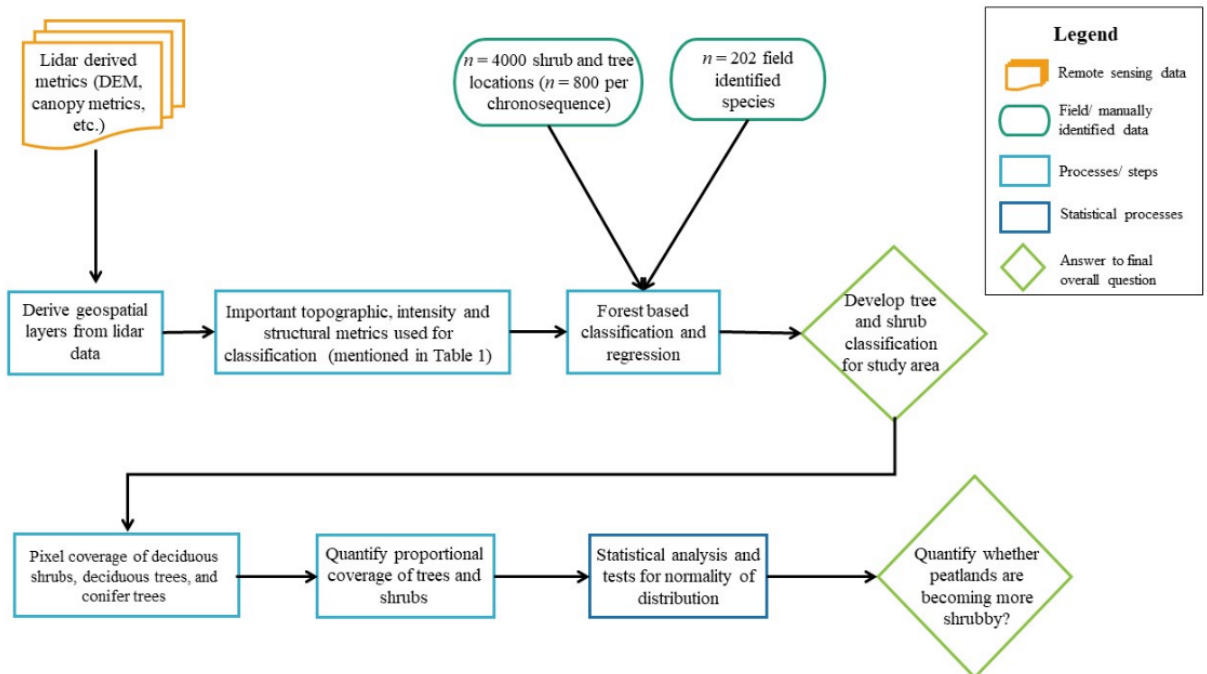
Figure 3. Flowchart of research methodology. The flow chart shows the input data and steps taken to develop the tree and shrub classification.